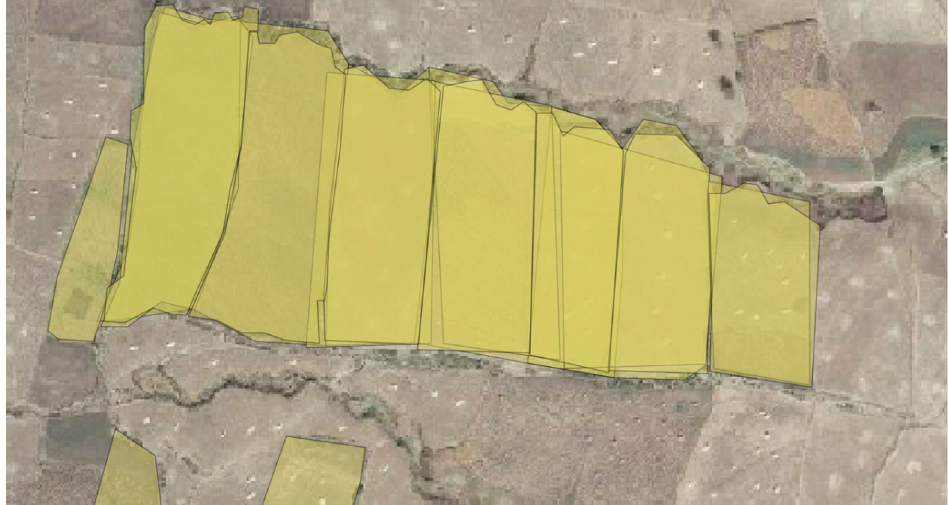
Figure 3. An example of multiple field boundaries digitized in CLE for the same image tile and displayed in a GIS. The digitized polygons are semi-transparent, with darker colors revealing where a field has been digitized by more than one Kifiya participant. Imagery © 2011 DigitalGlobe, Inc.